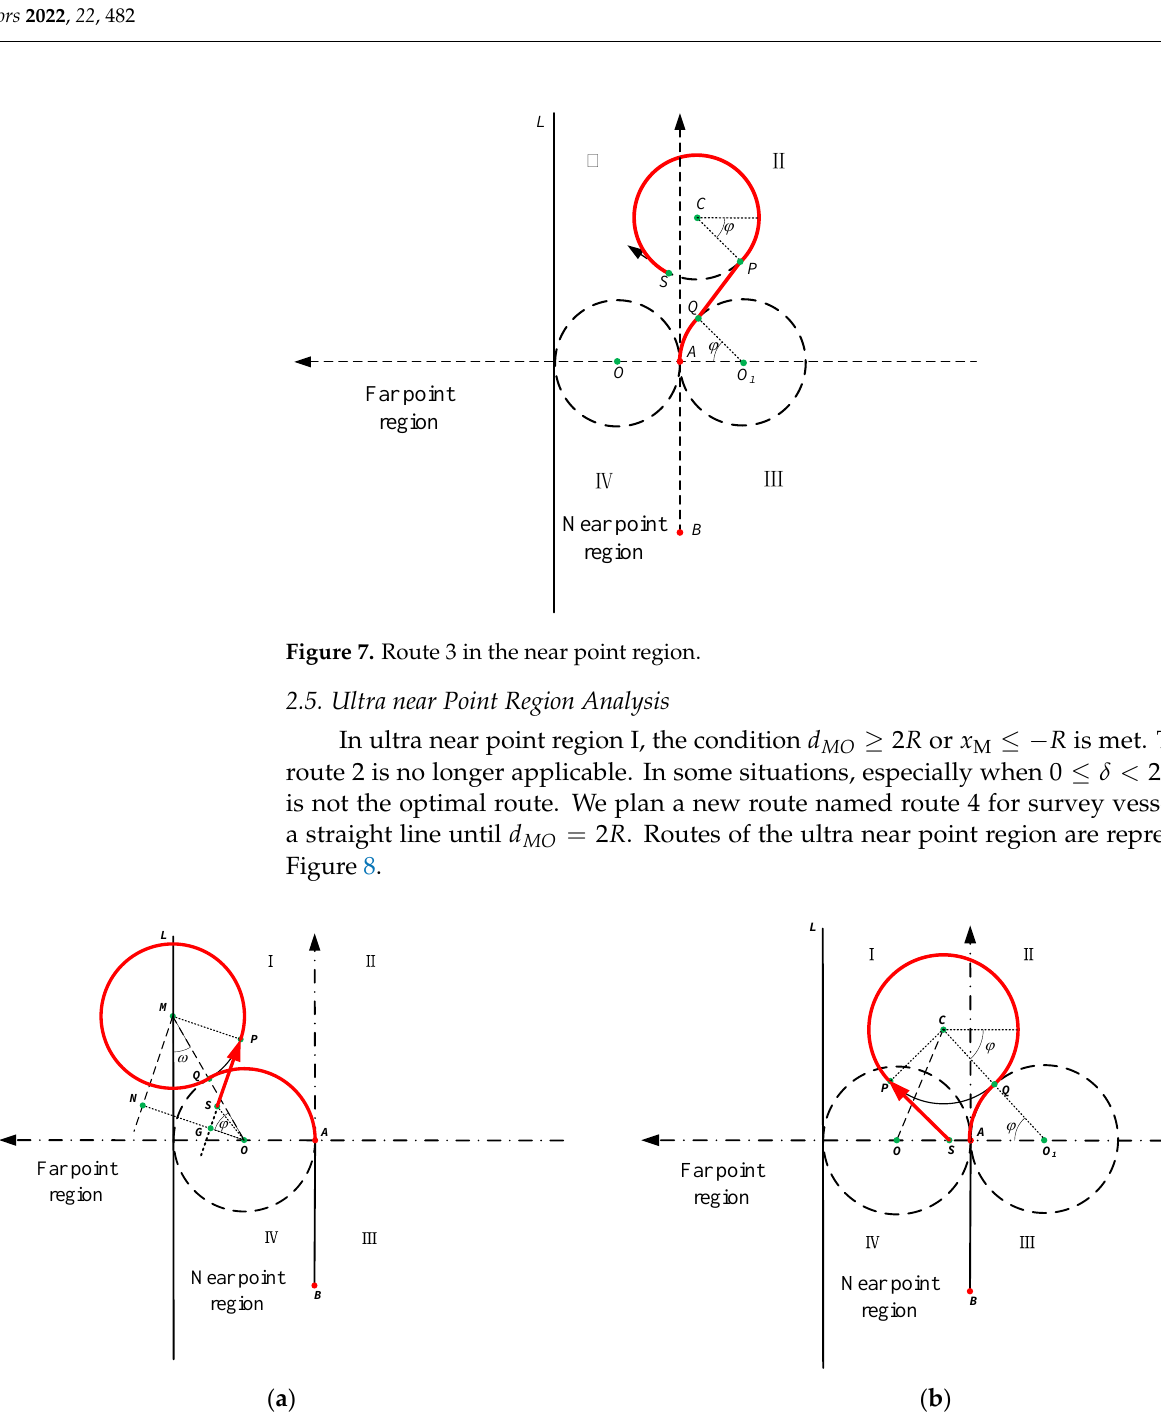
Figure 8. Routes of the ultra near point region: ( a ) route 4; ( b ) route 5. In route 4, MN || SP , ON || MP , ON ⊥ MN , and SP are tangent to circle M . x S > R x y x O S